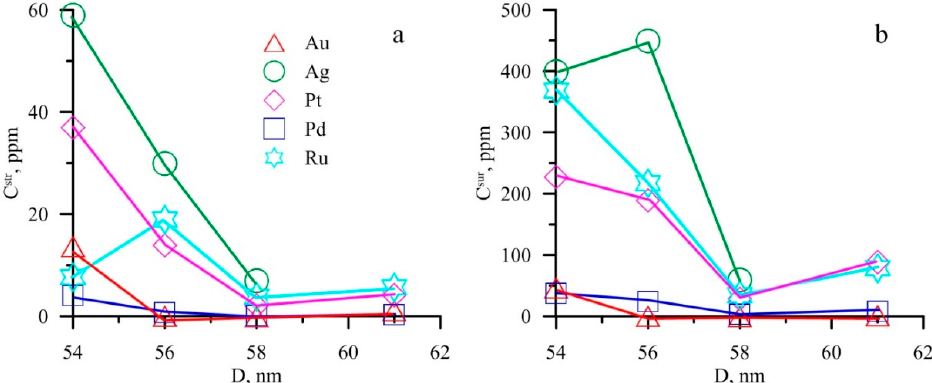
Figure 11. Dependences of NM contents in structurally ( a ) and superficially ( b ) bound modes on crystallite sizes in arsenopyrite crystals. See Tables 3 and 4 for numerical data.